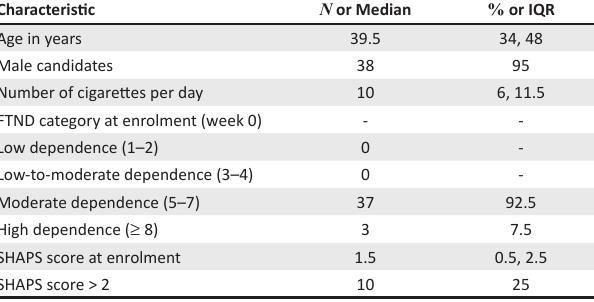
TABLE 1: Demographic characteristics.